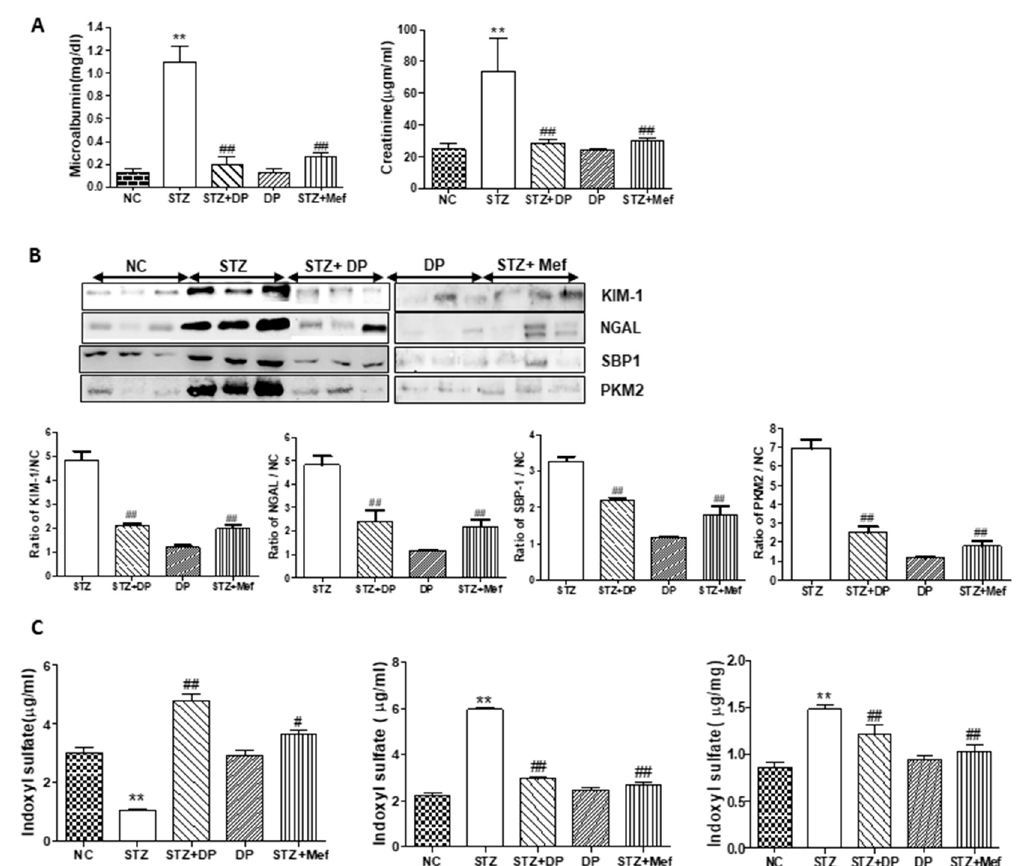
Figure 4. E ff ect of DP extract on changes in kidney injury biomarkers in the urine of STZ-induced diabetic rats. ( A ) Changes in urinary microalbumin and creatinine. Values are expressed as the mean ± S.D. for 6 rats. Statistical analysis was performed by one-way ANOVA followed by the Tukey’s HSD post hoc test for multiple comparisons. ** p < 0.01 compared to vehicle control; ## p < 0.01 compared to STZ-treated group. ( B ) Changes in the urinary excretion of kidney injury biomarkers in STZ-induced diabetic rats by the administration of DP and metformin. Representative Western blots of kidney injury molecule-1 (KIM-1), neutrophil gelatinase-associated lipocalin (NGAL), selenium binding protein-1 (SBP1), and pyruvate kinase muscle isozyme M2 (PKM2) levels in the urine of rats. Statistical analysis was performed by one-way ANOVA followed by Tukey’s honestly significant di ff erence test (HSD) post-hoc test for multiple comparisons. ** p < 0.01 compared to vehicle control; # p < 0.05, and ## p < 0.01 compared to the STZ-treated group. ( C ) Changes in the levels of 3-indoxyl sulfate (3-IS) in STZ-induced diabetic rats after treatment with DP extract and metformin. Concentration of 3-IS in the urine, serum, and kidney tissues was measured by HPLC analysis. Values are expressed as the mean ± S.D. for 6 rats. Statistical analysis was performed by one-way ANOVA followed by Tukey’s HSD post hoc test for multiple comparisons. ** p < 0.01 compared to vehicle control; # p < 0.05 and ## p < 0.01 compared to the STZ-treated group.